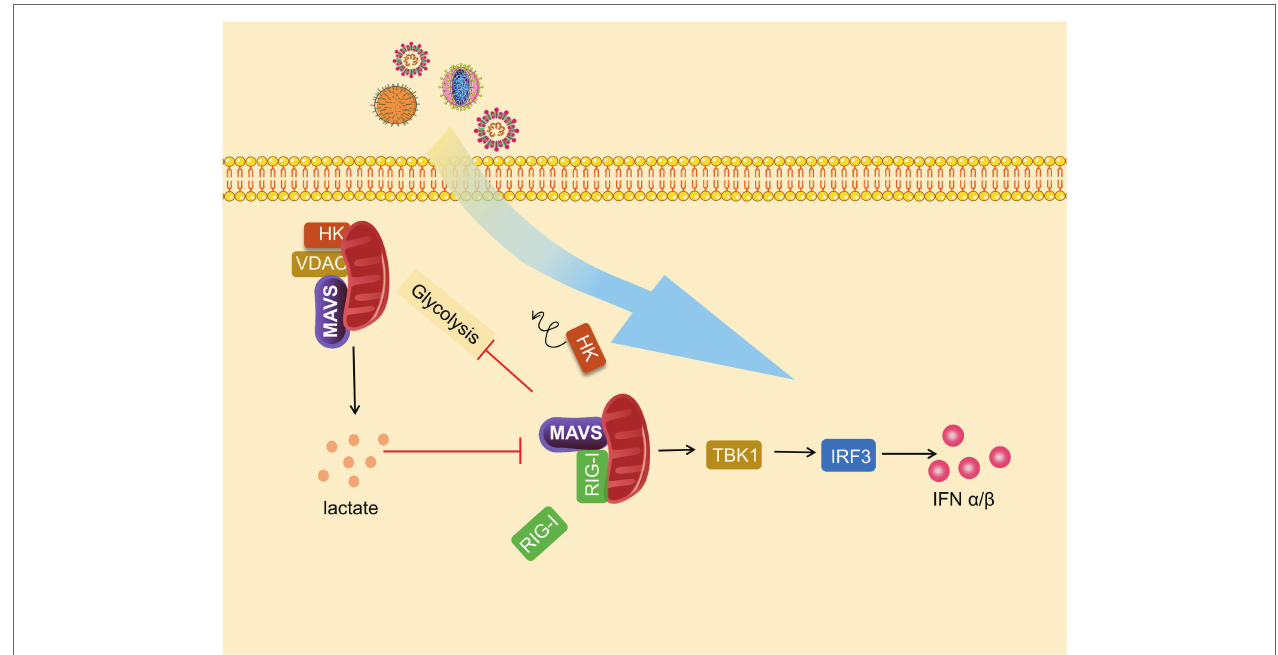
FIGURE 3 | Mitochondrial antiviral signaling protein (MAVS) is a bridge between immunity and glycolysis. Viruses promote hexokinase (HK) activity and lactate production and subsequently impress TANK-binding kinase 1 (TBK1)-IRF3 activation and IFN-I production. Mitochondria HK activity inactivated, and glycolysis is suffered blocks during RIG-I-like receptor (RLR) activation. Lactate negatively regulates RLR-mitochondrial antiviral signaling protein (MAVS) signaling and following